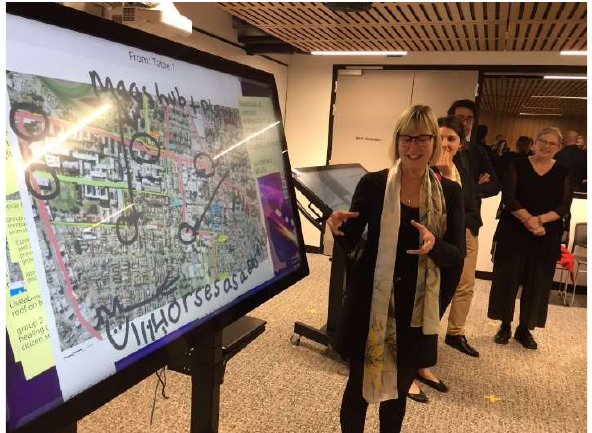
Figure 1 Multi-touch tables in action during the Randwick LL